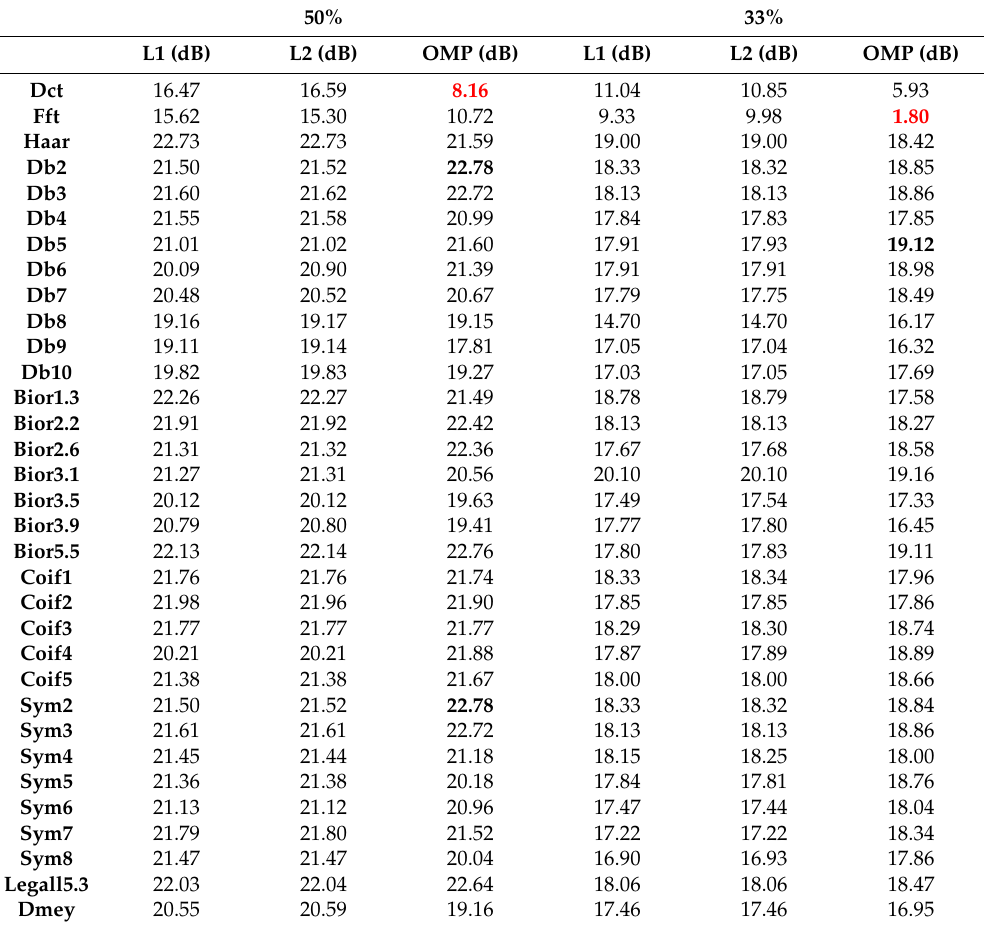
Figure 16. Radar image (without application of CS techniques) of the building shown in Figure 15. Table 2. PSNR calculated with different bases and recovery methods for experimental data acquired at the seven-storey